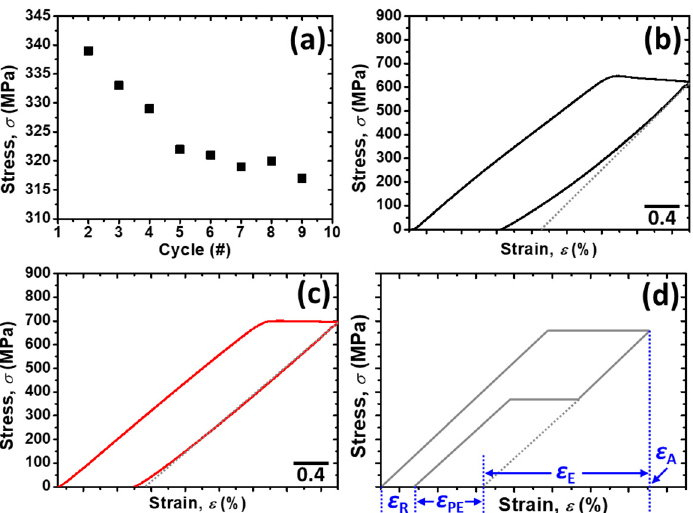
Figure 7. ( a ) Stress for the first yielding stress (i.e., stress for SIMT) of the Ti–4Au–20Ta alloy, ( b ) the ninth cycle in the cyclic loading–unloading tensile test of the Ti–4Au–20Ta alloy, ( c ) the ninth cycle in the cyclic loading–unloading tensile test of the Ti–4Au–30Ta alloy, and ( d ) the illustration for the explanations of the terms in the SS curve. Where ε A indicates the total applied strain, ε E suggests the elastic shape recovery strain, ε PE corresponds to shape recovery strain brought by pseudoelasticity, and ε R represents the remaining strain after unloading.